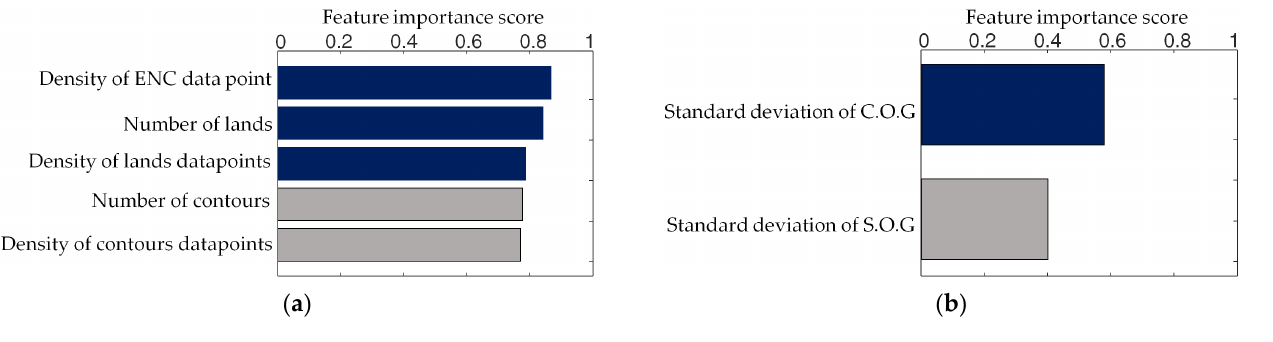
Figure 7. Results from the feature selection of the area and OS classes. ( a ) Area class. ( b ) OS class. Based on the feature selection result, the final adopted features are listed in Table 6.